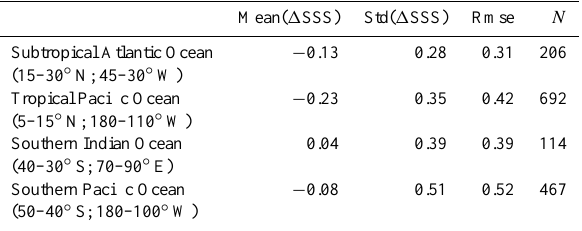
Table 1. Comparison of SMOS SSS (10day, 100 × 100km 2 aver- age) collocated with ARGO SSS in the various regions indicated on Fig. 1.